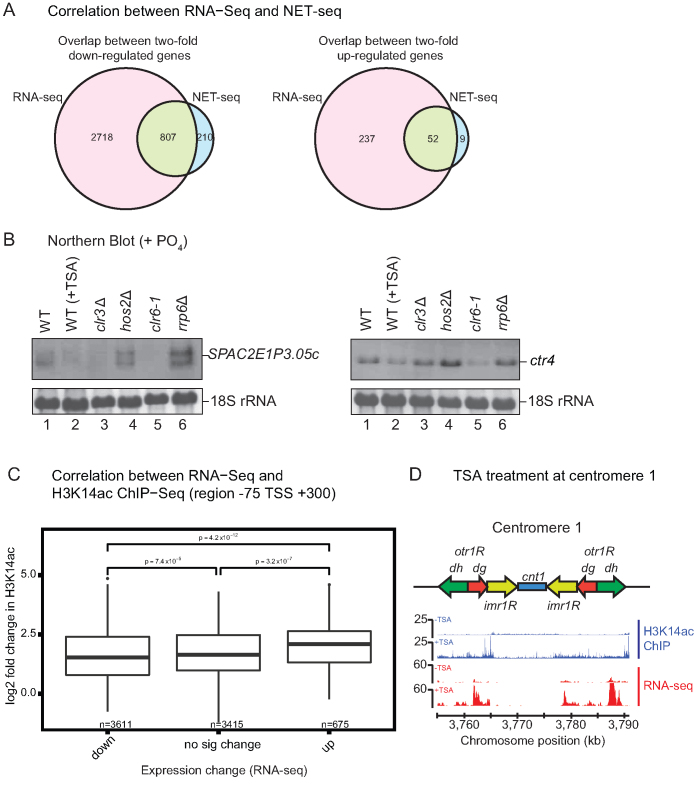
Genome-wide analyses. (A) Venn diagrams comparing genes identified by RNA-seq and NET-seq to be either down-regulated (left) or up-regulated (right) by treatment with TSA. (B) Northern blot analysis of RNA isolated from the indicated strains grown in YES and probed for SPAC2E1P3.05c (left) and ctr4 (right). 18S ribosomal RNA serves as a loading control. (C) Genes were split, according to RNA-seq, into down-regulated, up-regulated or no significant change in TSA. The log2 fold change in H3K14ac of these different groups is shown as box plots. (D) Distribution of H3K14ac (blue) and RNA levels (red) at centromere 1 from untreated (–TSA) and treated (+TSA) samples. A map of S. pombe centromere 1 showing centromeric otr1 regions comprising dg and dh repeats, imr1 region and cnt1 is shown.